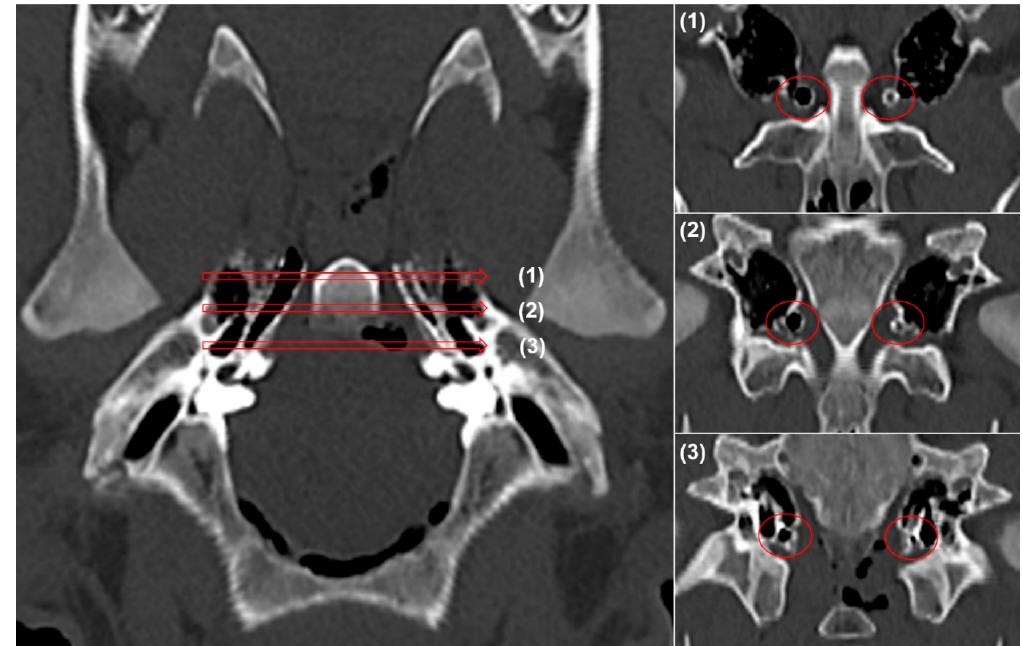
Figure 3. Coronal computed tomography image showing segments of the stented ETs, where the stents were present in the ( 1 ) proximal, ( 2 ) middle, and ( 3 ) distal portions. The axial CT images of the proximal portions of the stents show fully expanded stents in both ETs (red circles). The axial CT images show a gradual decrease from the proximal to the distal portion of the stented ET.